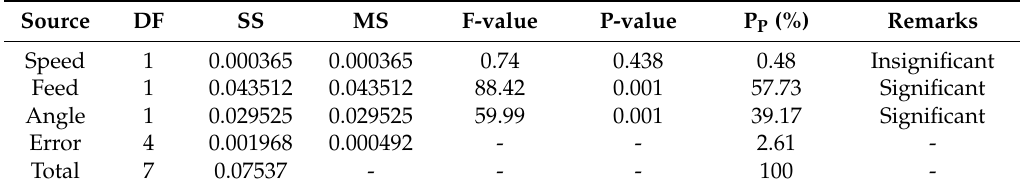
Table 11. ANOVA results for the tool distance from exit edge at full growth of fracture in separation